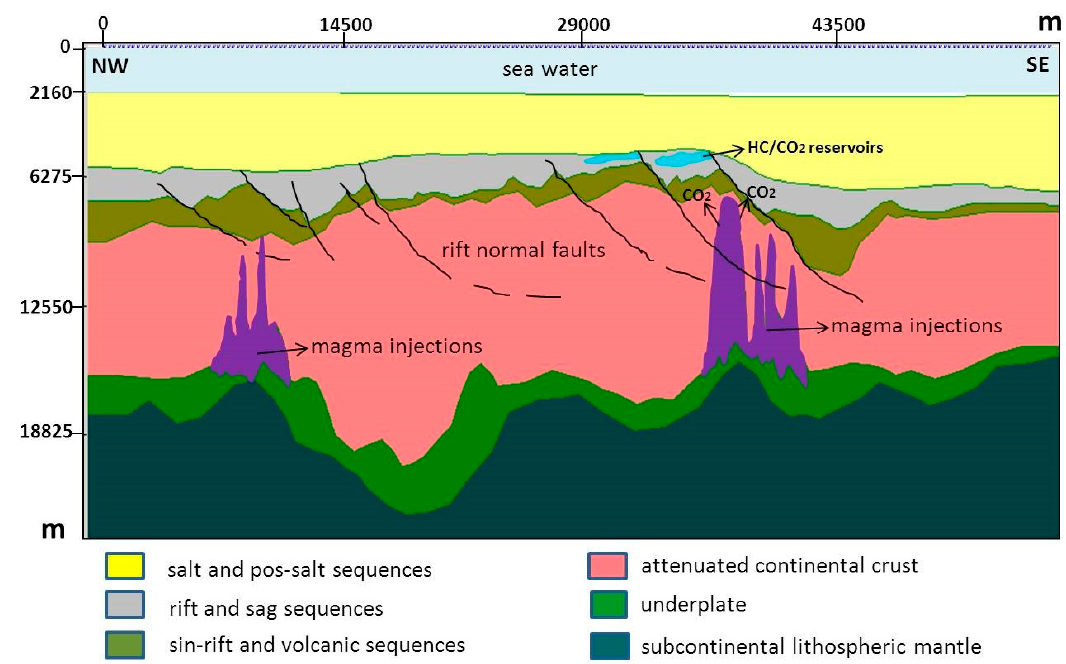
Figure 7. Modeled section based on magnetic, gravity and seismic information. The wells located on the region of the major intracrustal intrusion contain the highest amount of CO 2 found so far on the Brazilian Continental Margin. Section location in Figure 6.